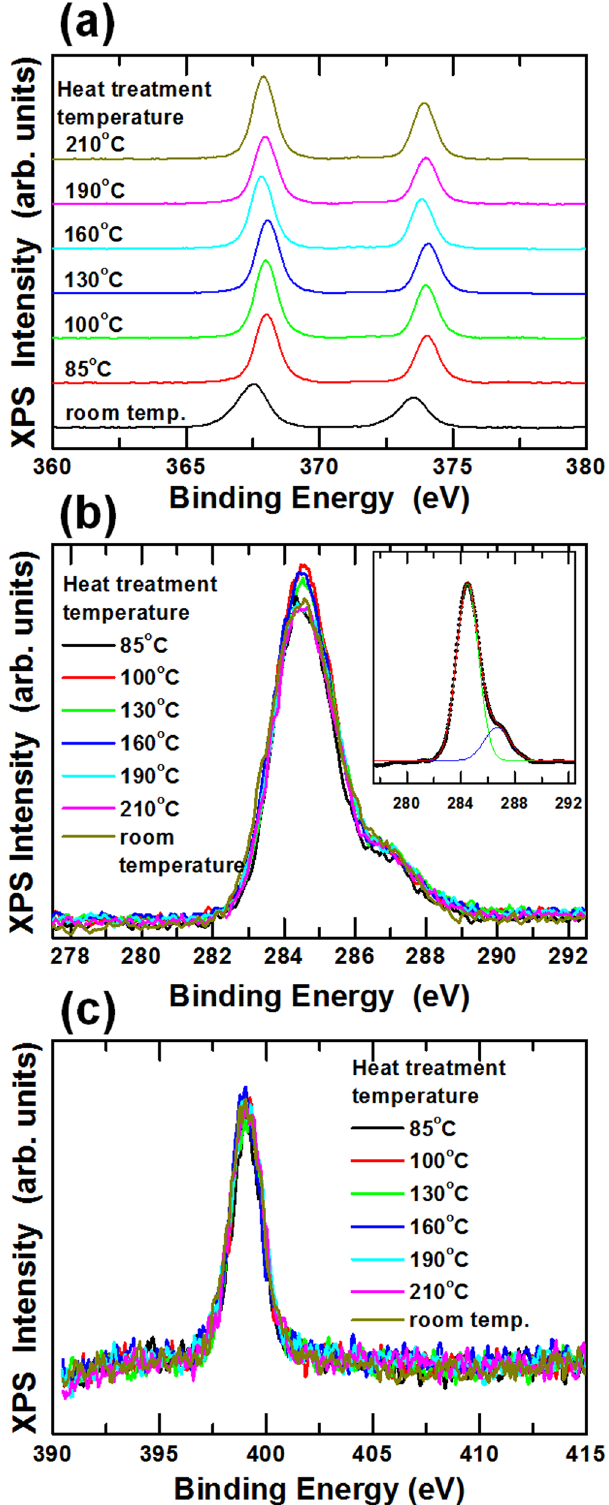
Figure 5. X-ray photoelectron spectroscopy spectra of the Ag NWs thermally-treated at room temperature, 85, 100, 130, 160, 190, and 210 °C for 10 min: ( a ) Ag 3d, ( b ) C 1s, and ( c ) N 1s